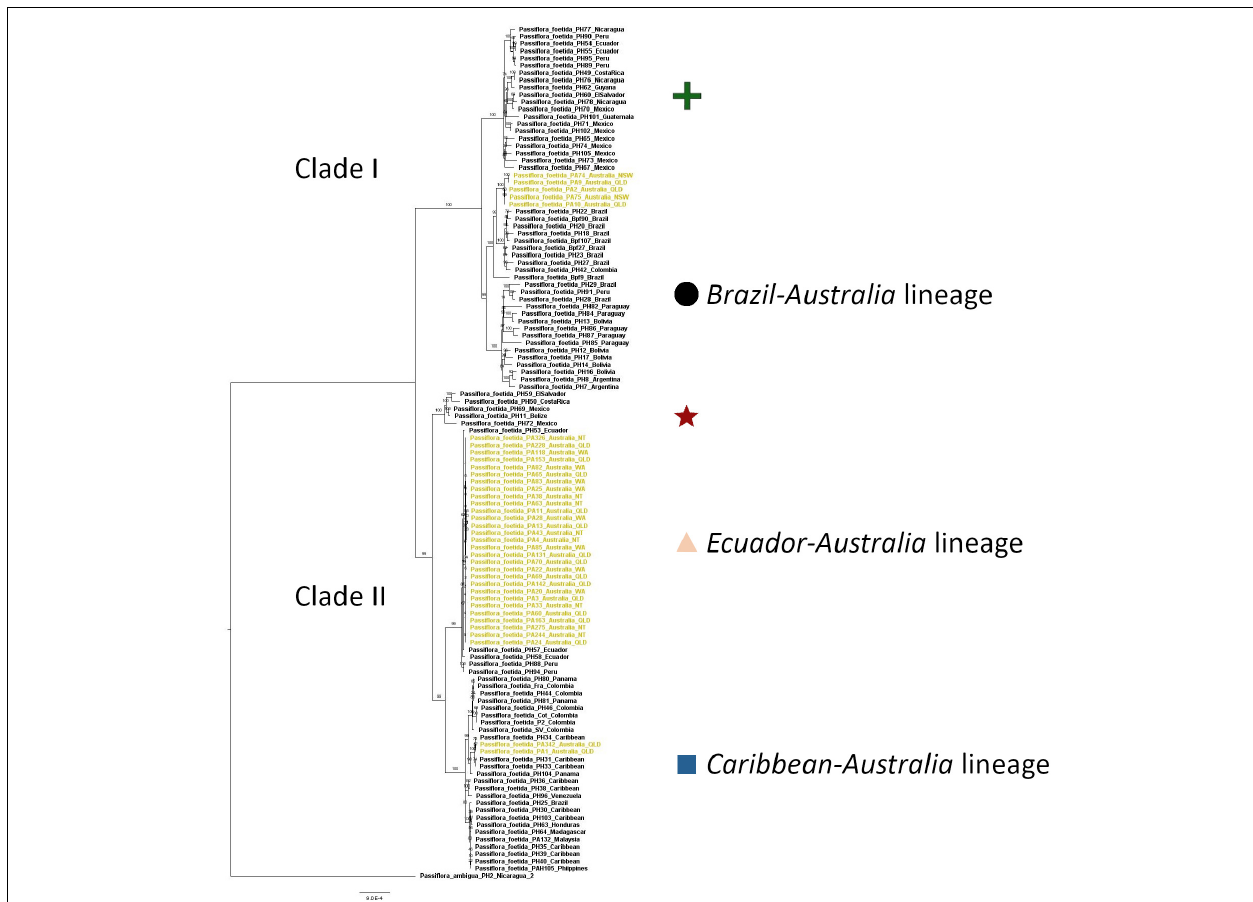
FIGURE 2 | Phylogenetic tree of samples in the foetida dataset (all samples of Passiflora foetida sensu lato plus Passiflora ambigua as an outgroup) based on the maximum likelihood analysis, shown with bootstrap confidence values. The samples from Australia are colored in khaki. Each of the clades are assigned a symbol which matches those used in the map presented in Figure 3